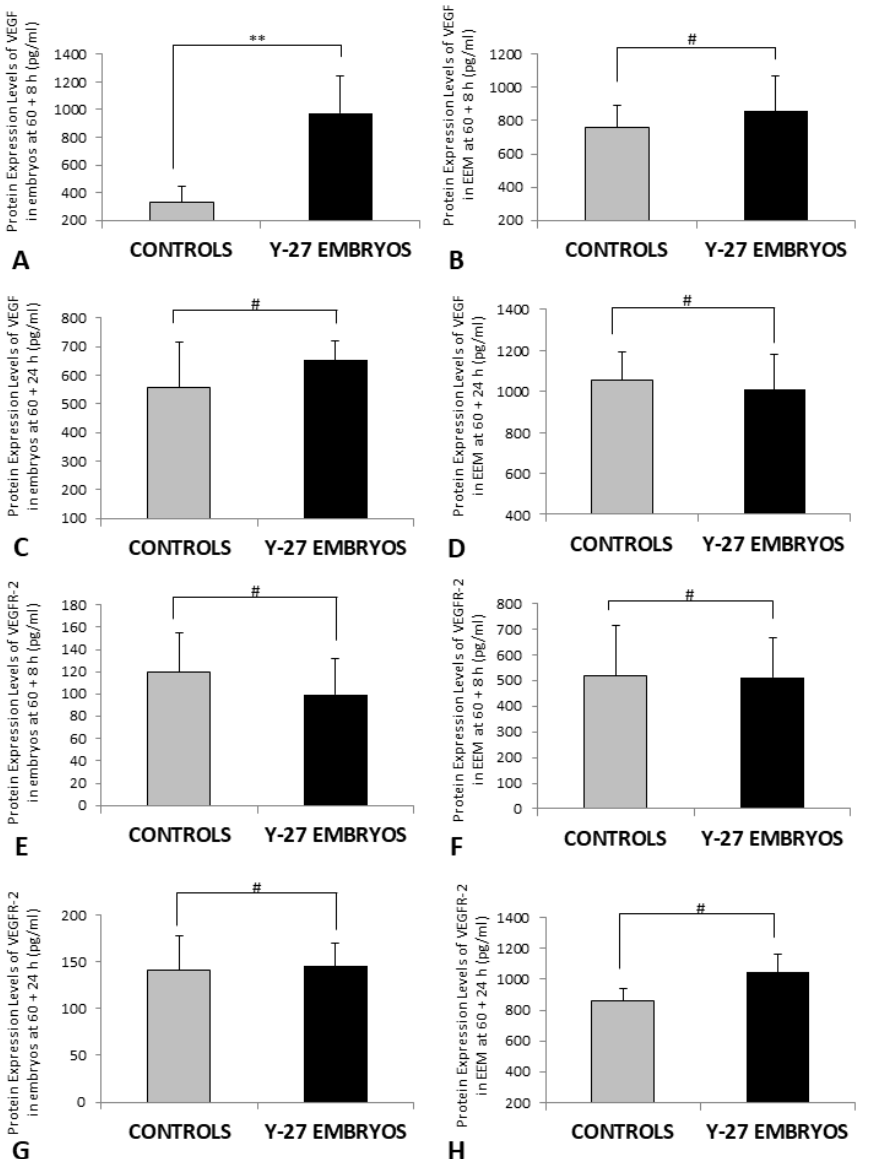
Figure 9. Protein expression of VEGF and VEGFR-2 in embryos ( A,C,E,G ) and EEM ( B,D,F,H ) of the control group and Y-27632 (500 µM) treatment group at 60 + 8 h and 60 + 24 h. Protein expression of VEGF was significantly higher in Y-27632-treated embryos in comparison to controls at 60 + 8 h ( A , ** p = 0.001). Protein levels of VEGF and VEGFR-2 were not different between embryos and membranes of the control and treatment group at other time points ( B – H , # p > 0.05). The vertical bars represent the SD. y-axis : Protein Expression Levels (pg/mL).